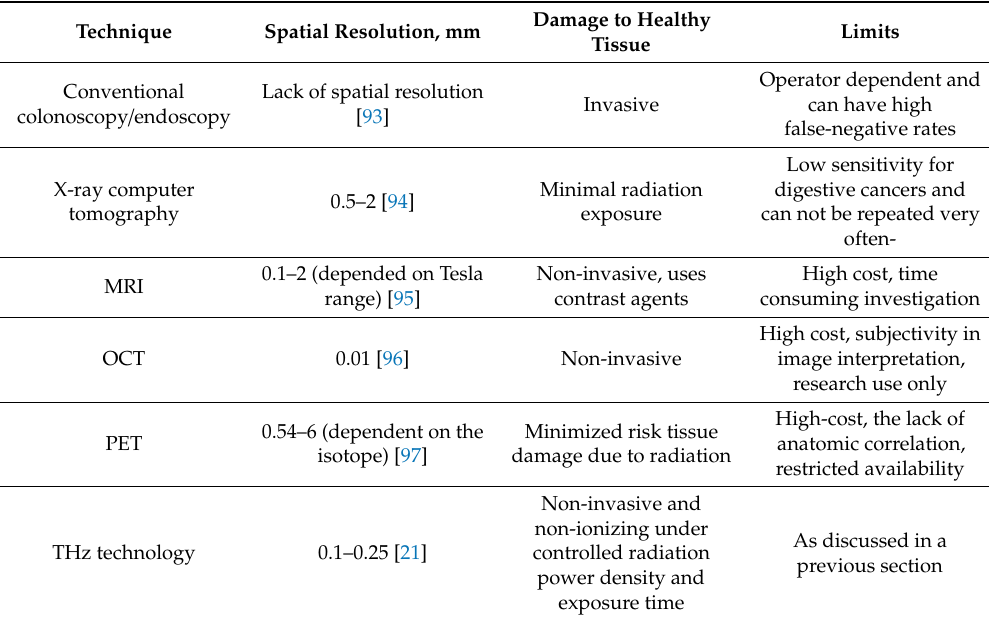
Table 2. Comparative performance parameters of imaging diagnostic